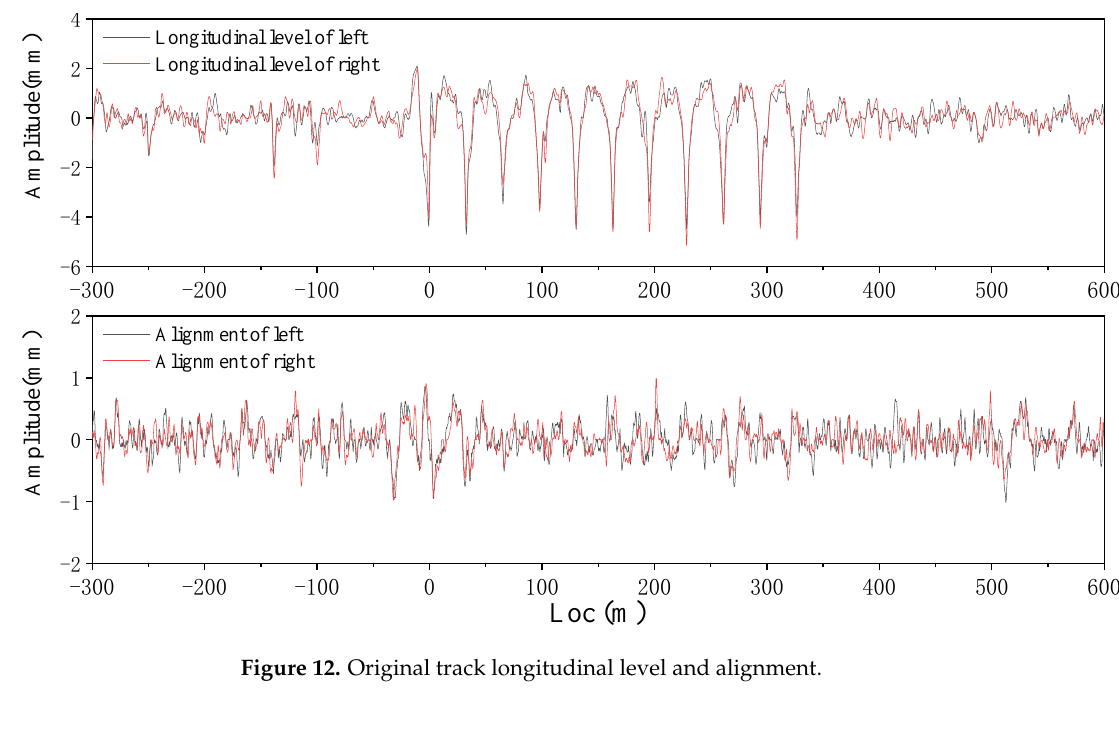
Figure 12. Original track longitudinal level and alignment.